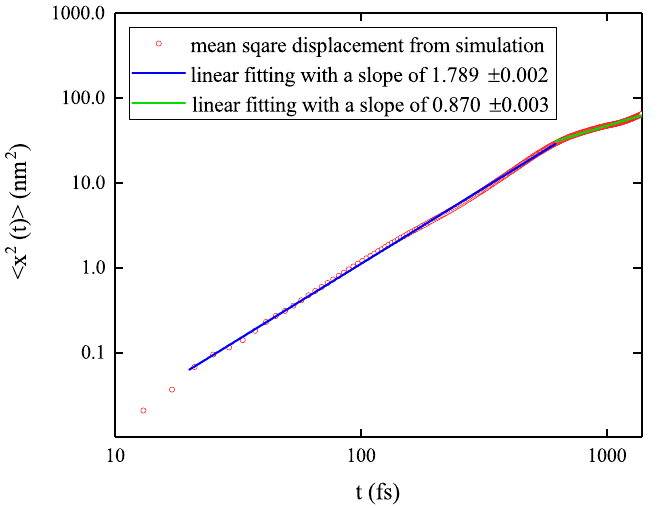
Figure 7. Bilogarithmic plot of the mean square displacement as a function of time for the exciton diffusion in a B850 chain containing 11 rings. The open circles are the results from the simulation which is initiated from the second lowest exciton state of the central ring (ring 6). The red (green) line is the linear fitting curve for the short (long) time regime. The fitting slopes are shown in the legend.